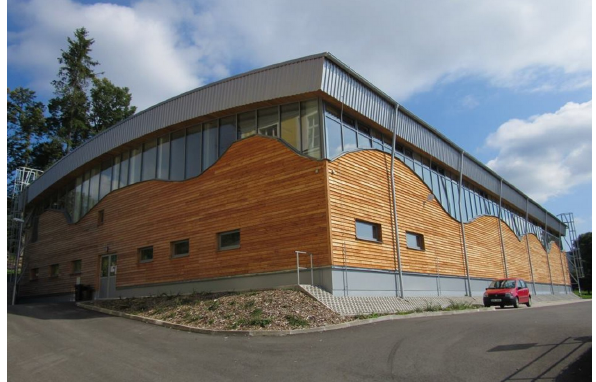
Figure 1: Sport facility in Kašperské Hory – outside view